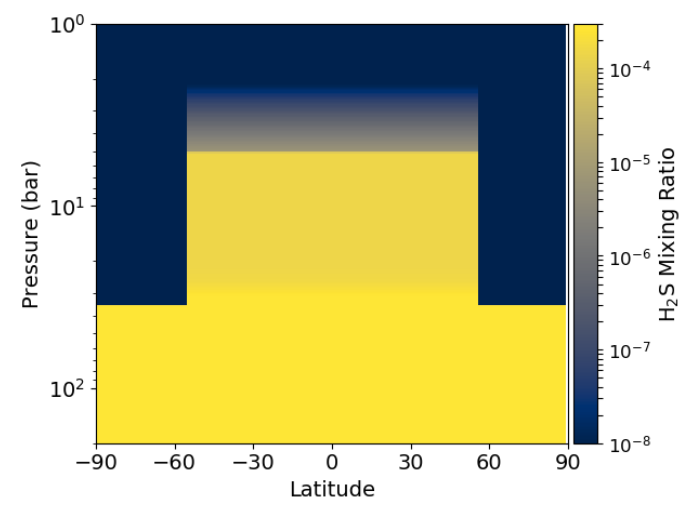
Figure 16. The latitudinal distribution of the H 2 S profiles that best match the radio brightness temperatures as measured for Uranus